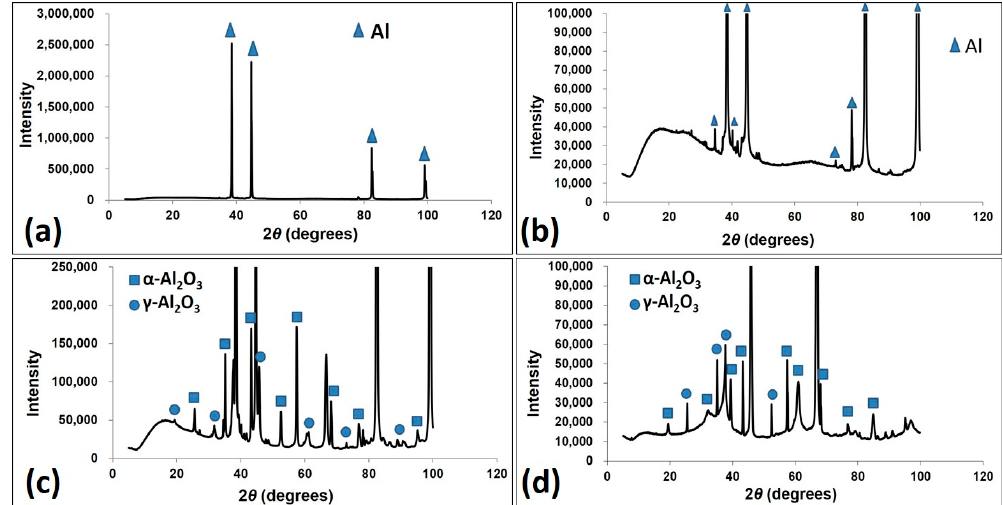
Figure 4. XRD spectra for coating layer of ( a ) HA, for highlighting lower peaks zoomed XRD spectra for ( b ) HA, ( c ) PEO and ( d ) PSC.